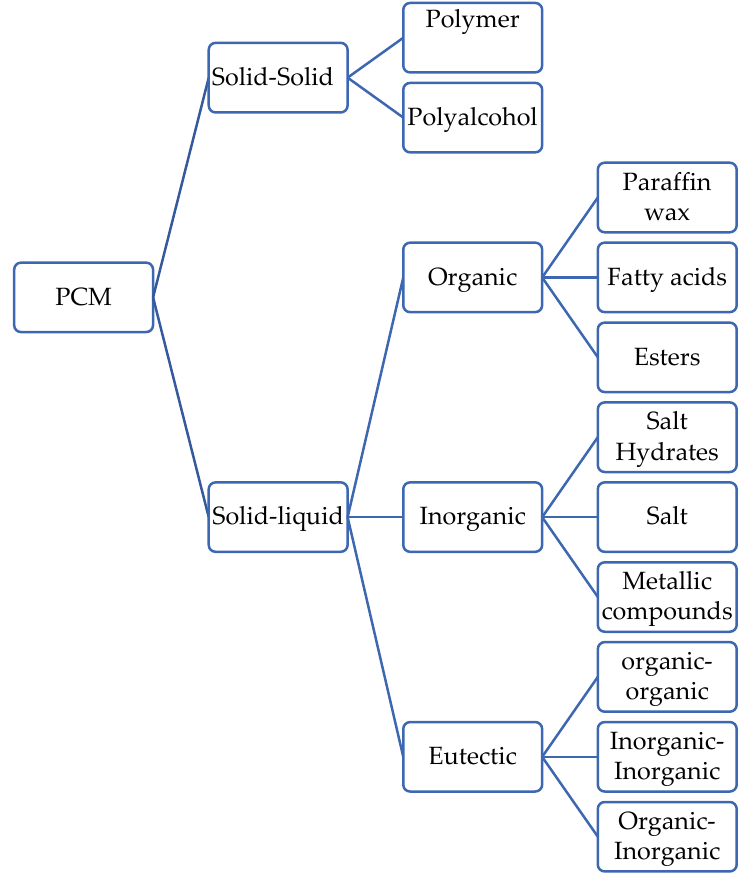
Figure 2. Classification of PCM [48].